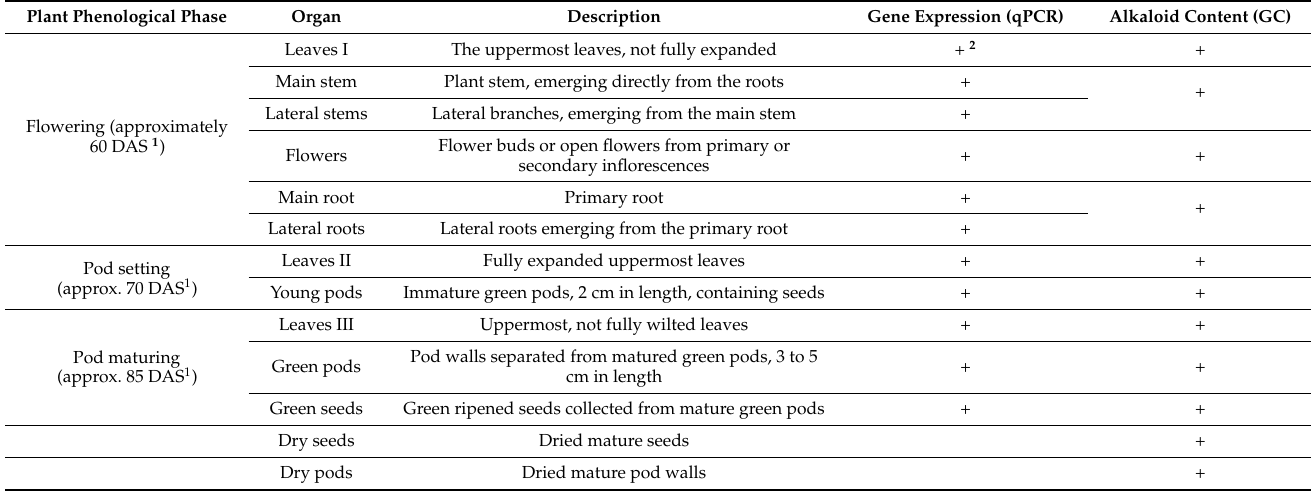
Table 2. Plant samples collected for two narrow-leafed lupin cultivars (Oskar and Regent), incorporated into gene expression qPCR analyses, as well as for evaluation of alkaloid content by gas chromatography (GC) assay. Detailed list of organs collected and analyzed each year is shown in Tables S1 and